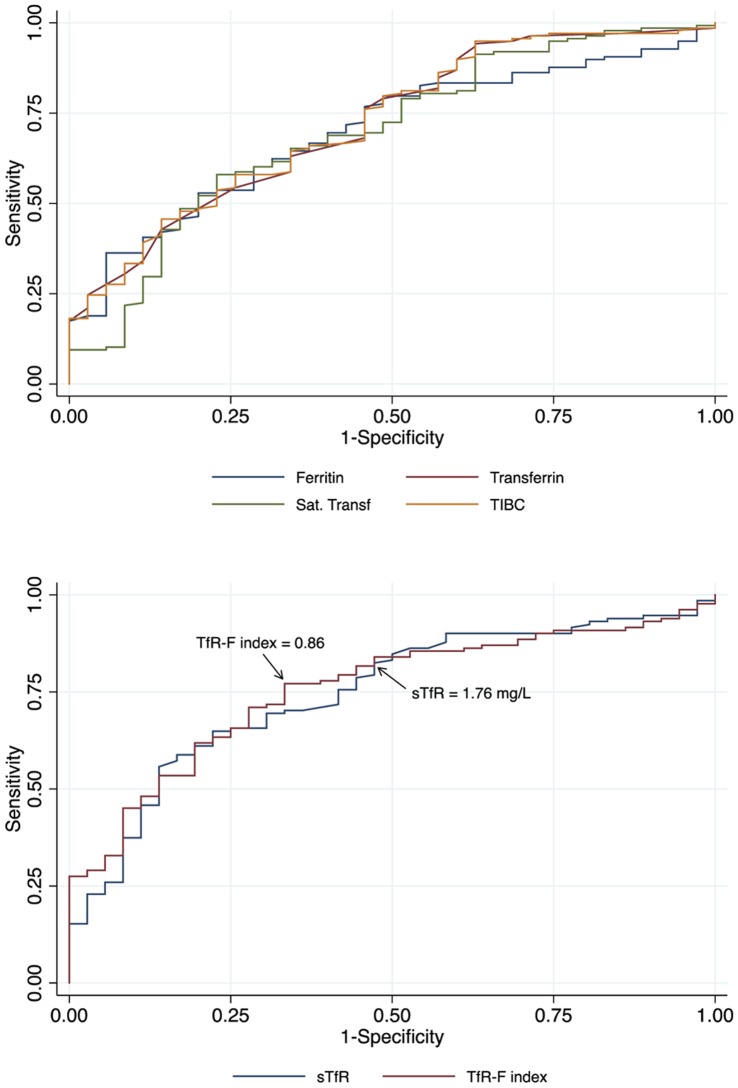
Receiver operating characteristic curves of the iron markers in the identification of iron stores deficiency.Cut-off values for sTfR and TfR-F index with the highest sensitivity to detect iron deficiency maintaining the specificity≥50% are indicated with arrows. Abbreviations: Sat. Transf., transferrin saturation; sTfR, soluble transferrin receptor; TfR-F index, transferrin-ferritin index; TIBC, total iron binding capacity.